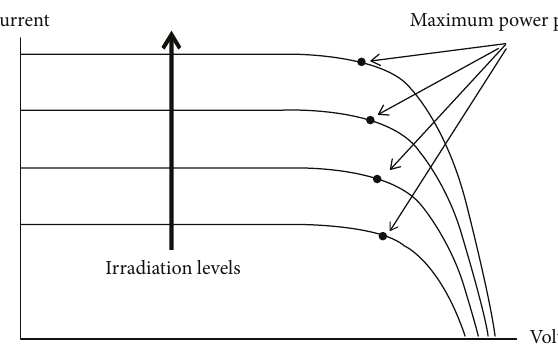
Figure 1: E ff ect of irradiance changes on I - V